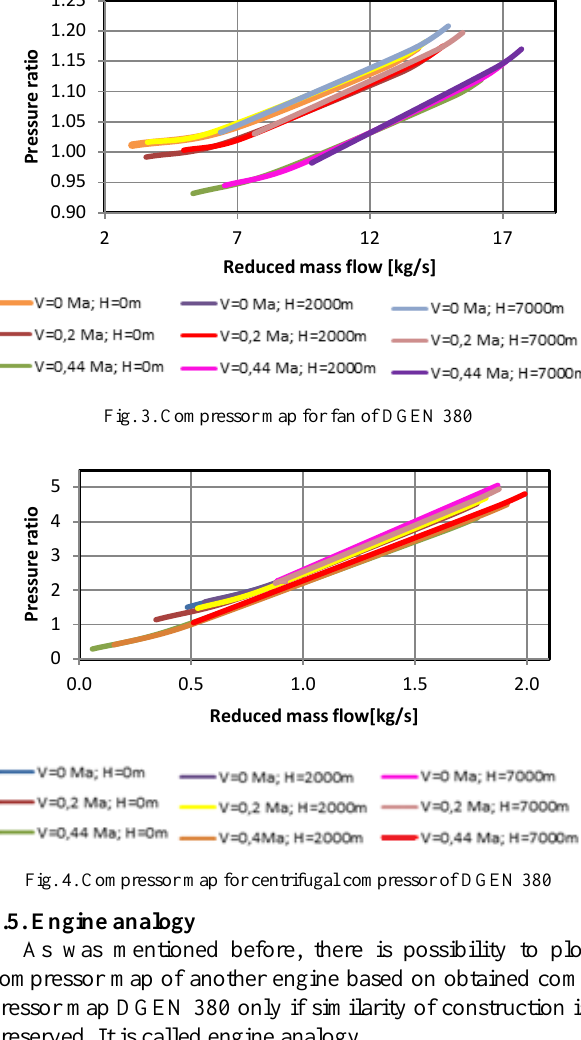
Table 4. Parameter of CFM 56-5B V = 0 Ma, H = 0 m